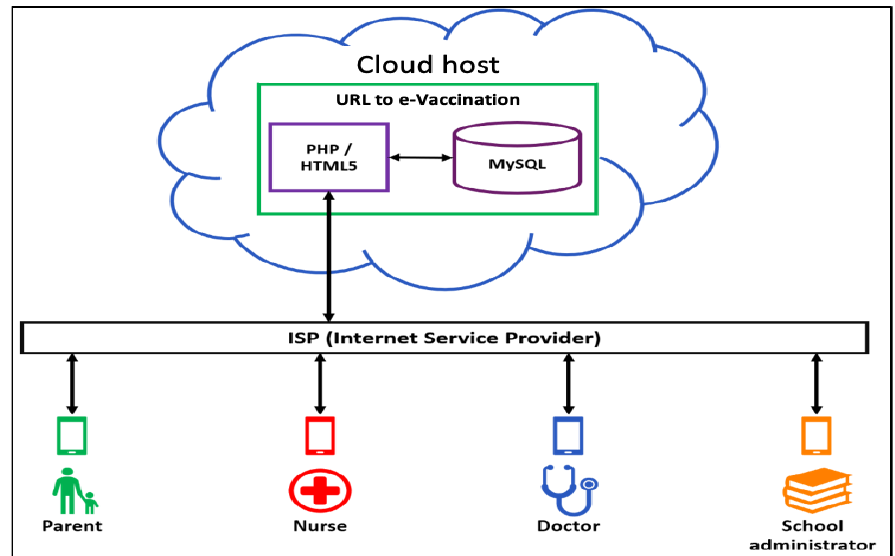
Figure 2: Architecture of e-Vaccination